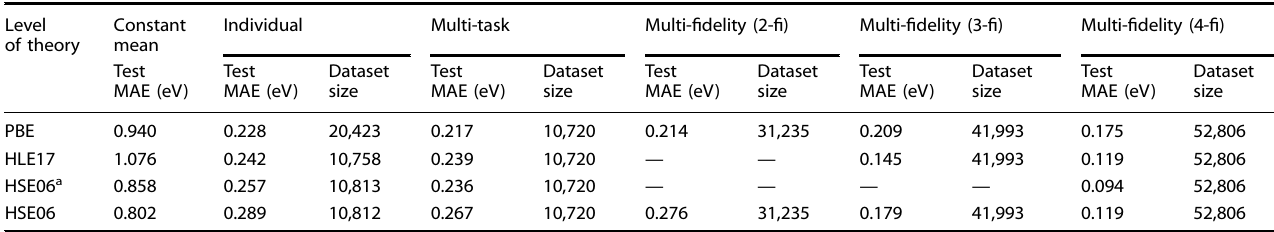
Table 1. Graph neural network performance for predicting band gaps at multiple levels of theory.